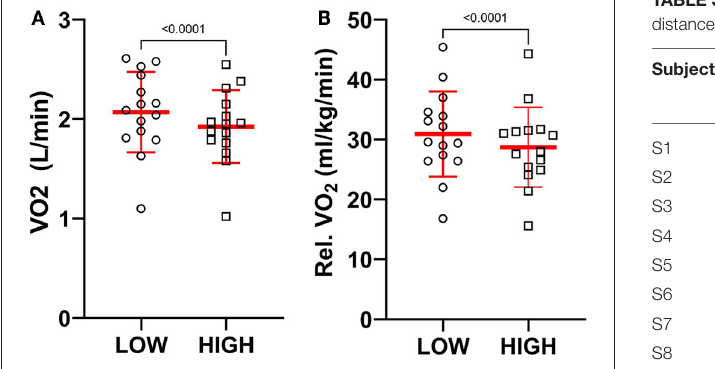
FIGURE 3 | A comparison of individual and mean (A) absolute and (B) relative oxygen consumption in the LOW and HIGH support conditions during the treadmill running task. A significant reduction in oxygen consumption was observed in the HIGH compared to LOW support conditions.